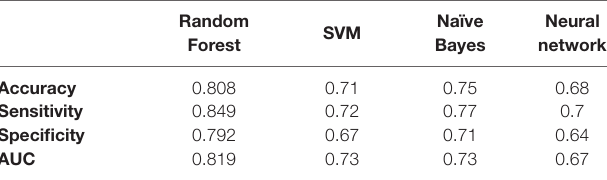
TABLE 3 | The accuracy, sensitivity, specificity, and AUC obtained for sMRI and fMRI when selecting the first 34 and 4 features, respectively. Random Forest